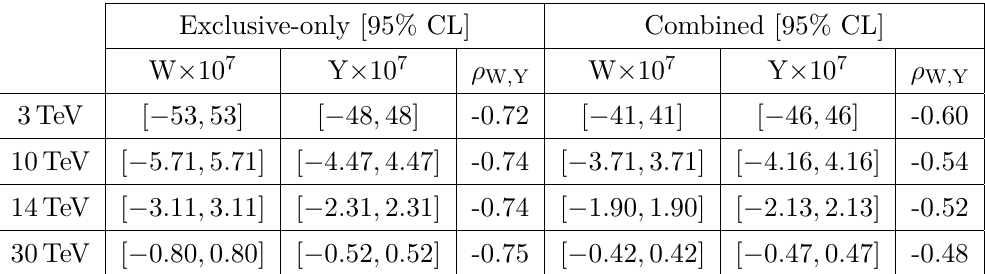
Table 4. Single-operator 95% CL reach and correlation for the W & Y parameters at different muon collider energies including only exclusive cross-sections and combining all measurements. Since the likelihood is dominated by the linear terms in the new physics parameters, the single parameter reach plus the correlation characterizes our results